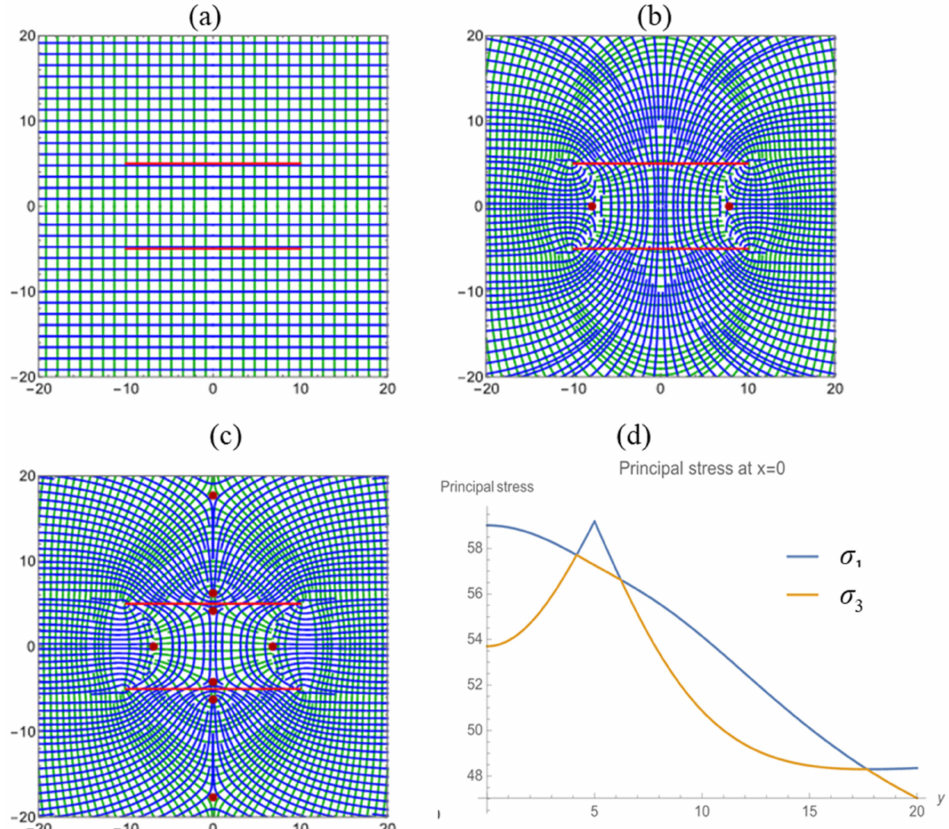
Figure 7. Stress trajectory solutions ( a ) when only the in-situ stress is adopted for the stress tra- jectory, ( b ) when the fracture net pressure is 20 MPa (the neutral points (red dots) are located at ( x , y ) = (7.86, 0) and ( x , y ) = ( − 7.86, 0); two more neutral points occur at the x = 0 line, beyond the field of view), ( c ) when the fracture net pressure is 10 MPa. There are four pairs of neutral points (red dots). The red dashed ellipse marks a so-called stress cage. ( d ) The principal stresses (in MPa) at x = 0, plotted along the line between ( x , y ) = (0, 0) and ( x , y ) = (0, 20). Crossings correspond to neutral points, where both of the principal stresses have the same magnitude, and their ranking based on magnitude σ 1 > σ 2 > σ 3 becomes indeterminate. A far-field anisotropic stress field is present, with the largest compressional principal stress trajectories outlined in blue and least principal stress trajectories outlined in